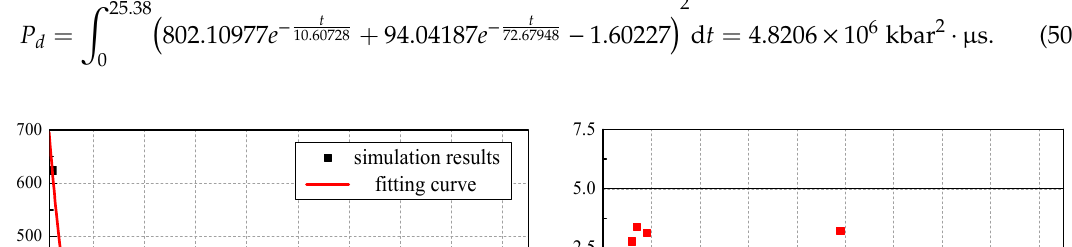
Table 7. Parameters of the debris and satellite tank used in calculation.